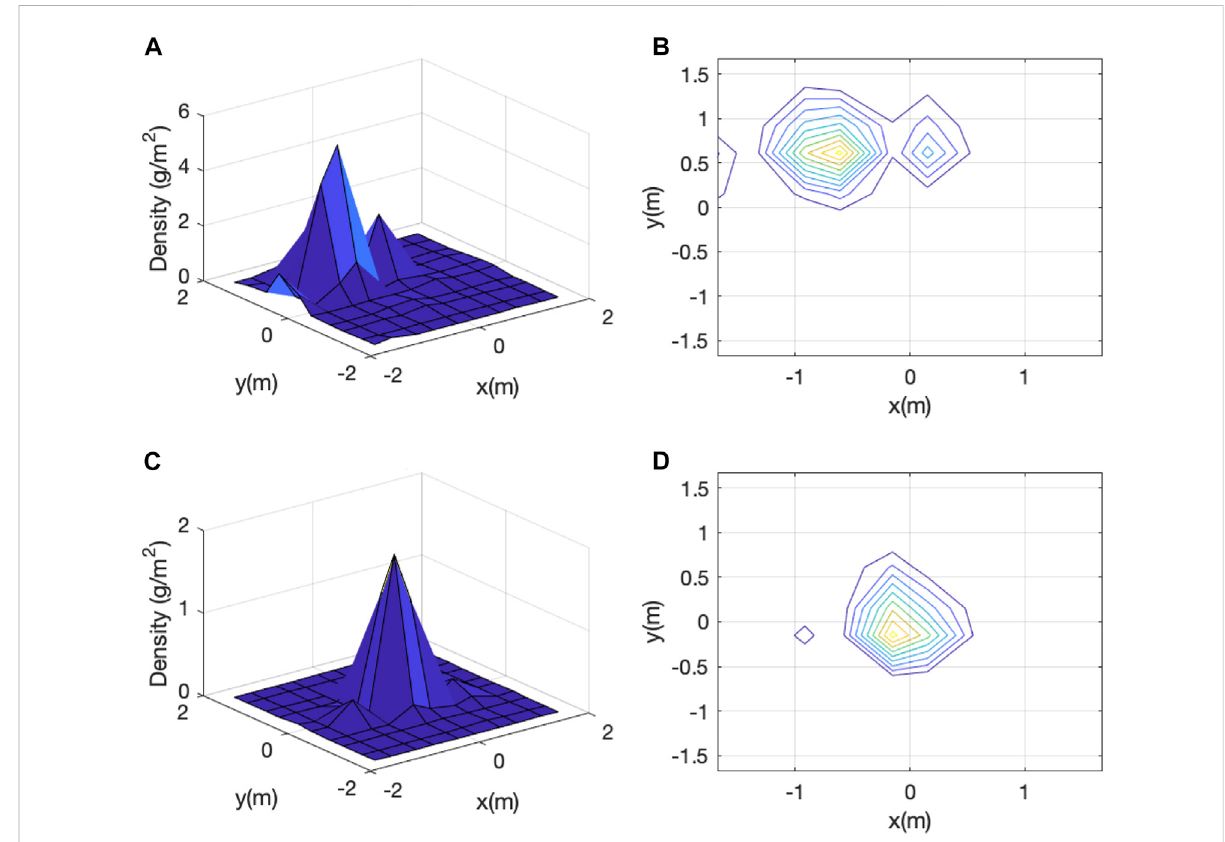
FIGURE 8 Raw vermiculite density data of two dispensing trials: (A) and (C) show the 3D plots and (B) and (D) show the corresponding contour plots.